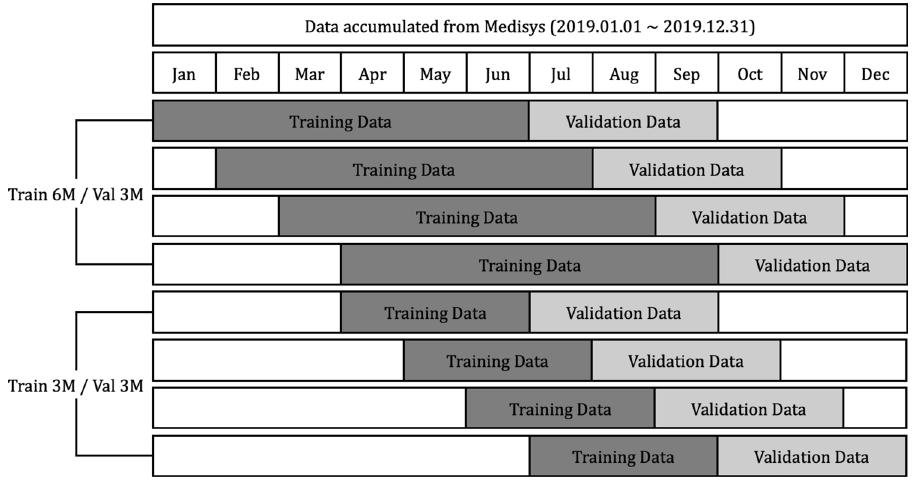
Figure 8. Using data crawled for a year, experiments are set as first, each model being trained using 6 months’ data, and predicting if the disease will outbreak or not; and second, each model being trained using 3 months’ data, and predicting if the disease will outbreak or not.